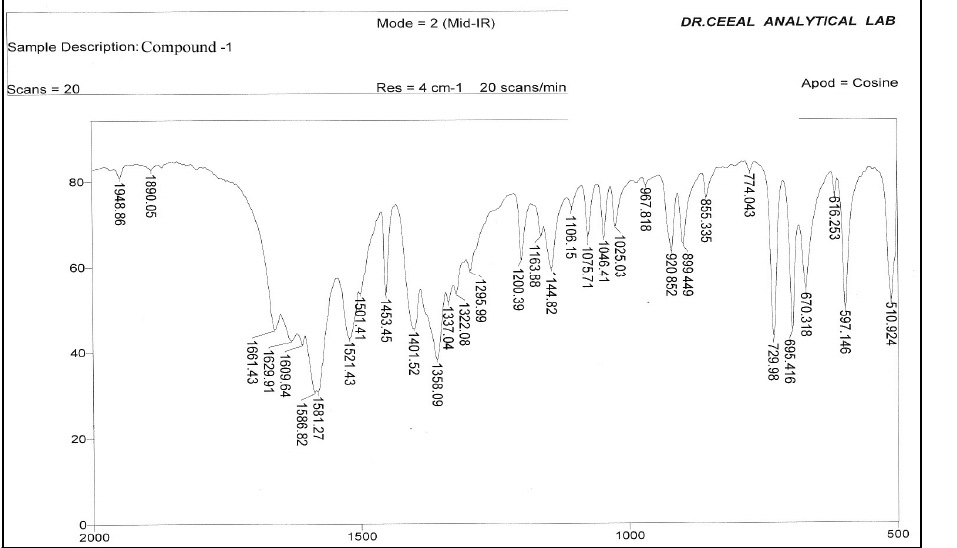
Figure 3. IR spectrum of synthesized